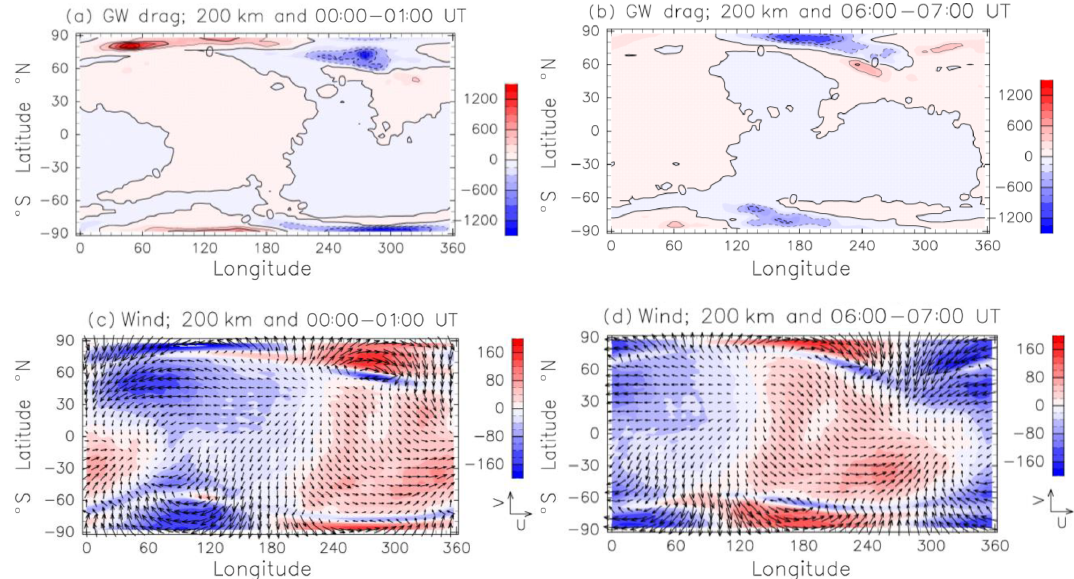
Figure 11. (a) Longitude–latitude section of the zonal GW drag at 200km height in June. Data are averaged between 00:00 and 01:00UT. Positive and negative values are eastward and westward acceleration, respectively. Units are meters per second per day. Contour intervals are 200ms − 1 d − 1 . (b) As in (a) except for the average between 06:00 and 07:00UT. (c) Vectors indicate the global distribution of the horizontal wind at 200km height obtained by EXP2. Data are averaged between 00:00 and 01:00UT in June. The vectors on the right-hand side indicate the zonal wind and meridional winds with magnitudes of 200ms − 1 . Color bars are the global distribution of the zonal-wind component at 200km height. Data are averaged between 00:00 and 01:00UT. (d) As in (c) except for the average between 06:00 and